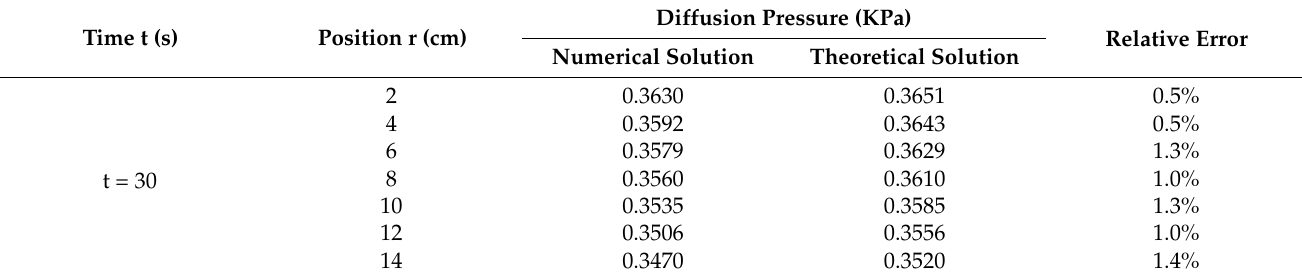
Table 2. Simulation results and analytical results of radial pressure distribution at different